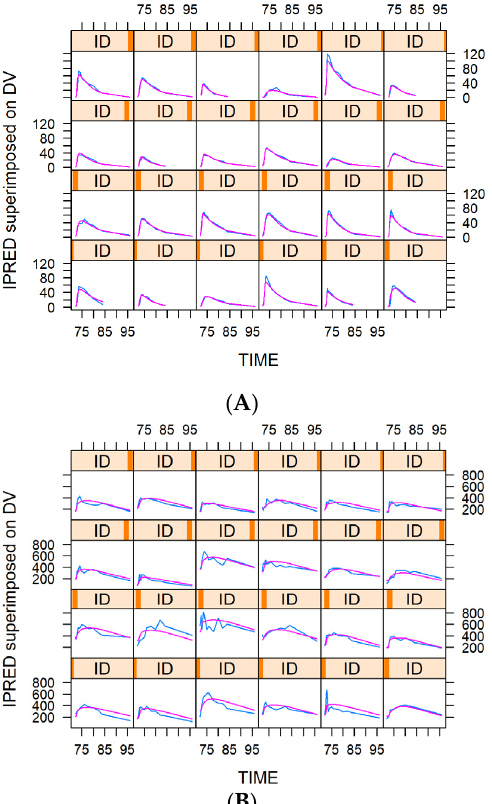
Figure A1. Plots for individual observations (blue) and predictions (red). ( A ) Primaquine, ( B ) Car- boxyprimaquine.